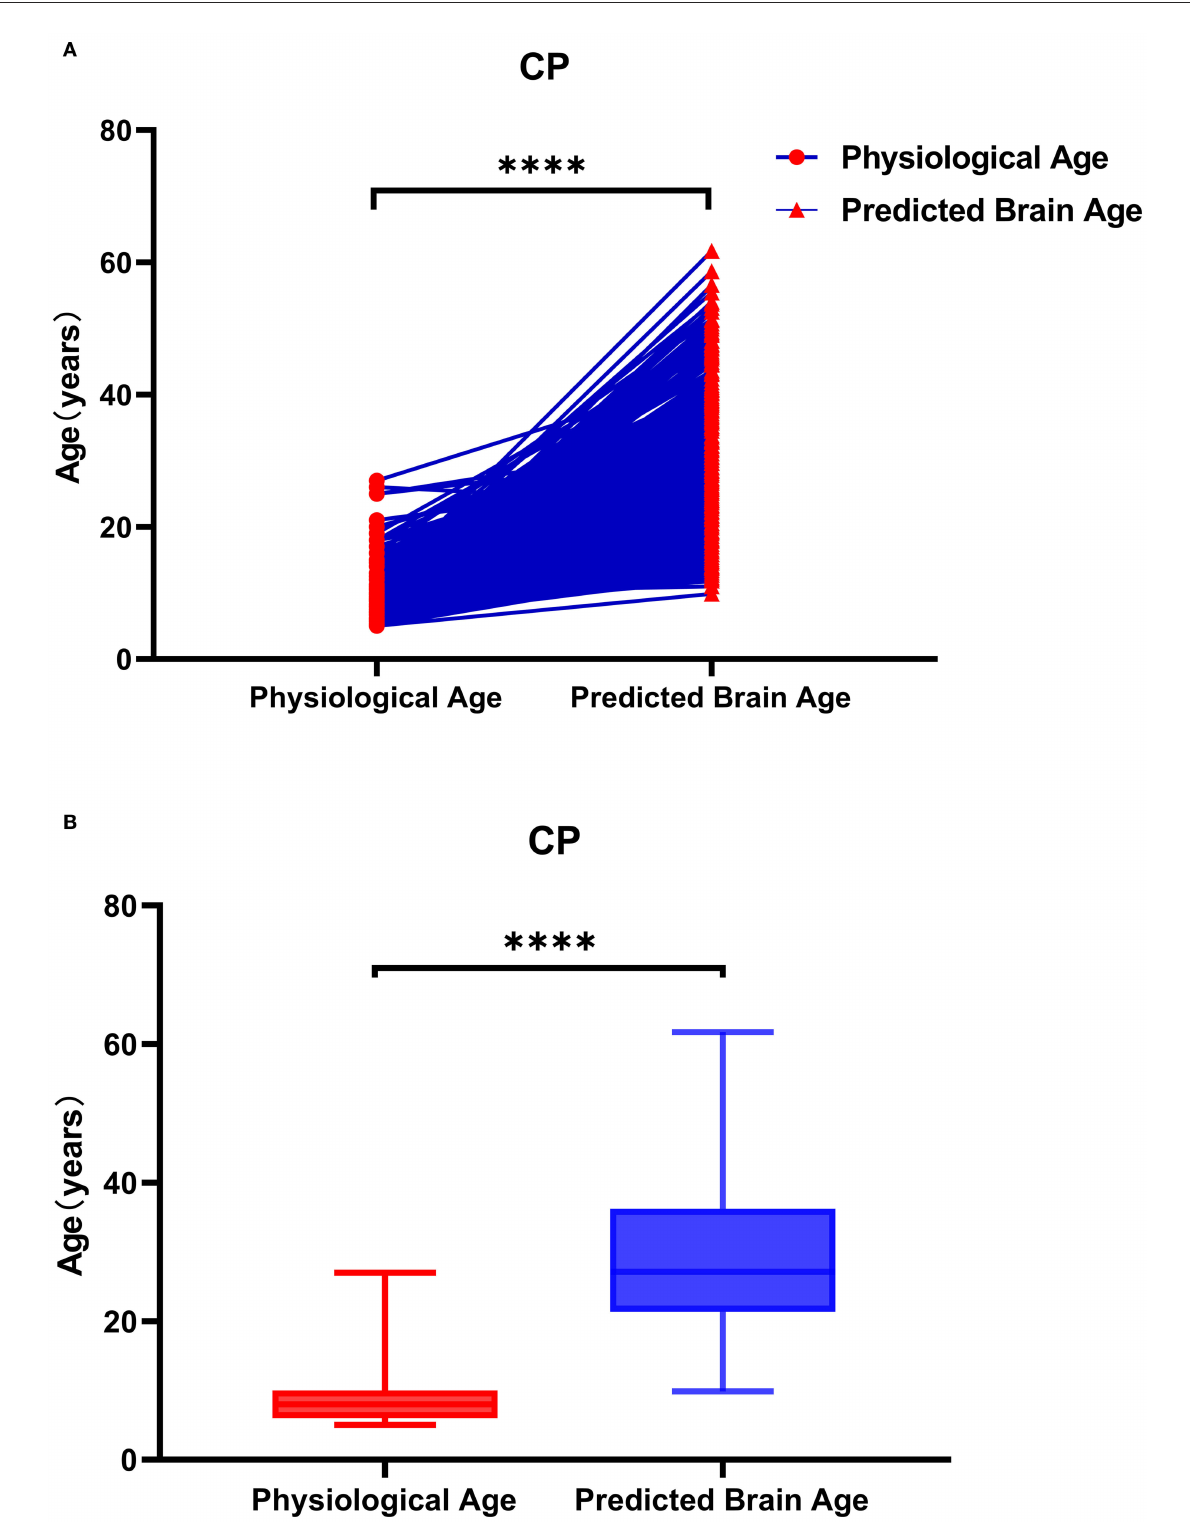
FIGURE6 Physiological age and brain age of patients with cerebral palsy. As shown in (A) , the data represented by the circle icon are the physiological age of the CP patient, and the triangle icon represents the corresponding actual brain age. As shown in (B) , the brain age of patients with CP is older than the physiological age. As shown in (A) , the data on the left are the physiological age of patients with CP, and the data on the right are the corresponding actual brain age. The brain age of patients with CP was greater than their physiological